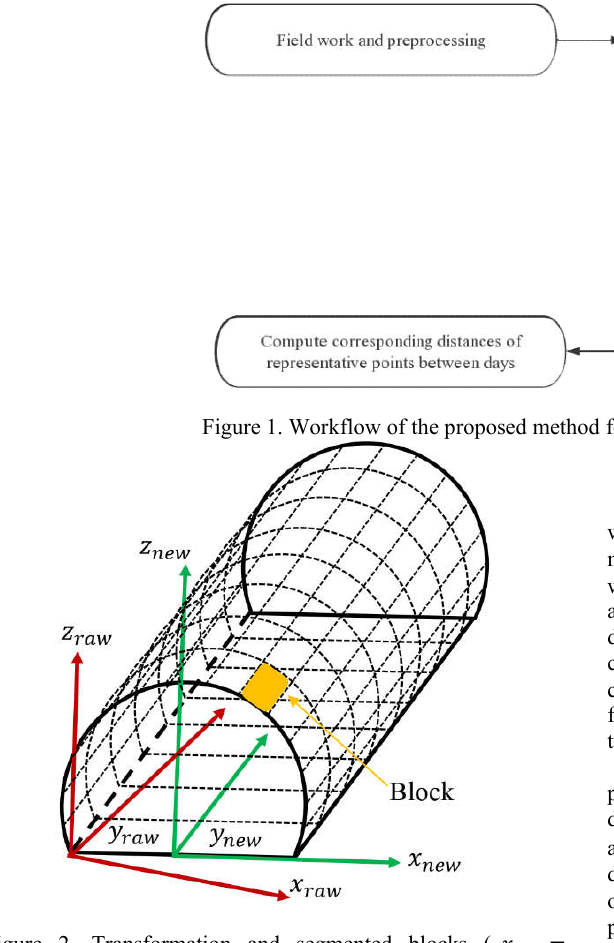
Figure 2. Transformation and segmented blocks (   =   ,  ,  denote the coordinates of the raw registered point clouds;   =   ,  ,  ) are the coordinates of points in the ‘new’ coordinate system; the yellow block is the example of a segmented